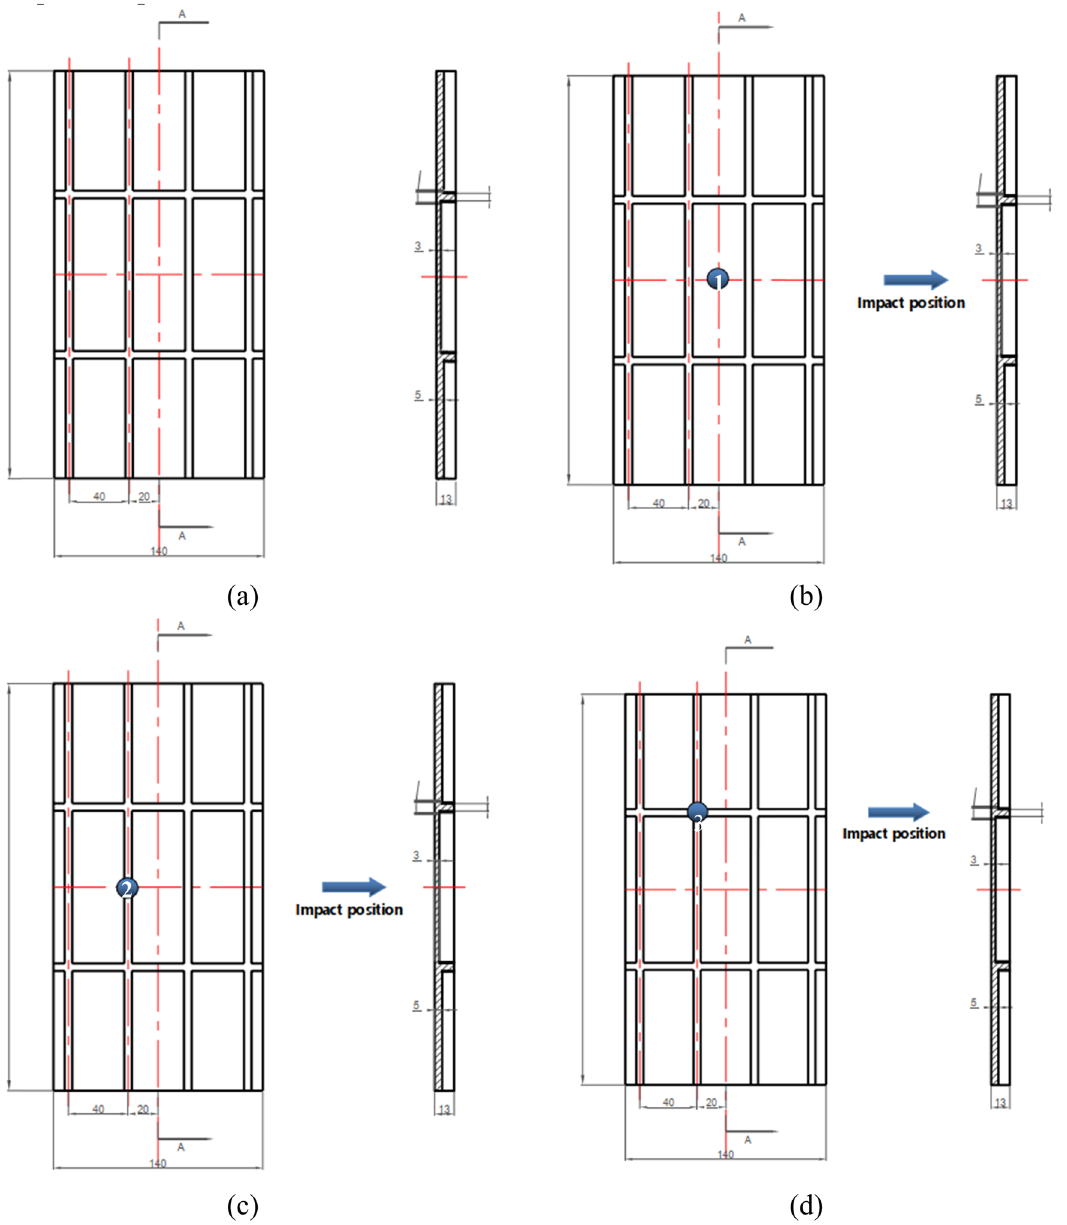
Figure 3: Impact position and impact direction: ( a ) intact specimen; ( b ) specimen without sti ff eners under the impact; ( c ) below the impact is the specimen at the midpoint of a single sti ff ener; ( d ) below the impact is the specimen at the intersection of the sti ff